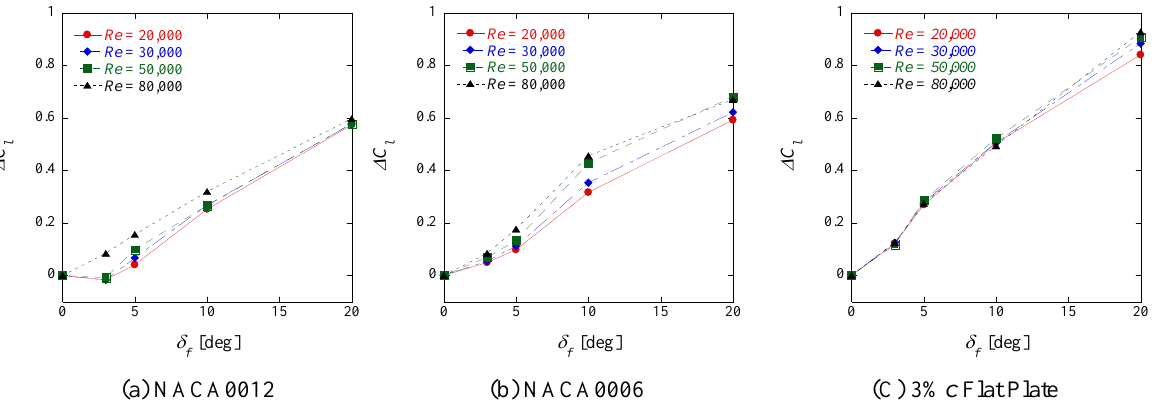
Fig. 8 Control surface effectiveness at  = 0 deg in the Reynolds number range from Re = 20,000 to Re = 80,000. The control surface effectiveness has both a Reynolds number dependence and non-linearity, except for 3% c flat